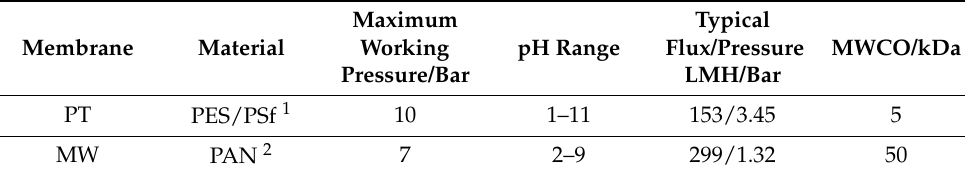
Maximum Typical Working pH Range Flux/Pressure MWCO/kDa Pressure/Bar LMH/Bar